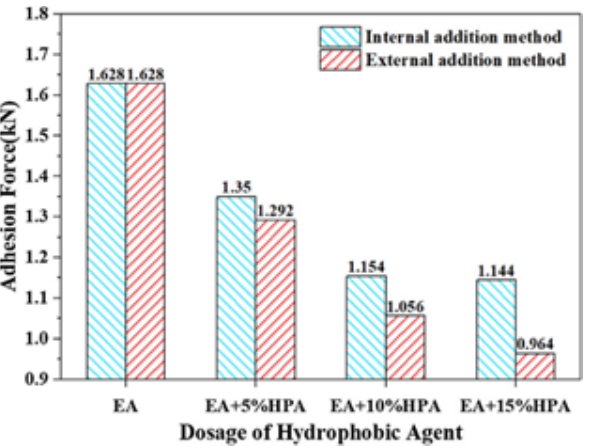
Figure 4. Comparison of the values for adhesion force for different methods of a hydrophobic agent addition. Reprinted with permission from [48].